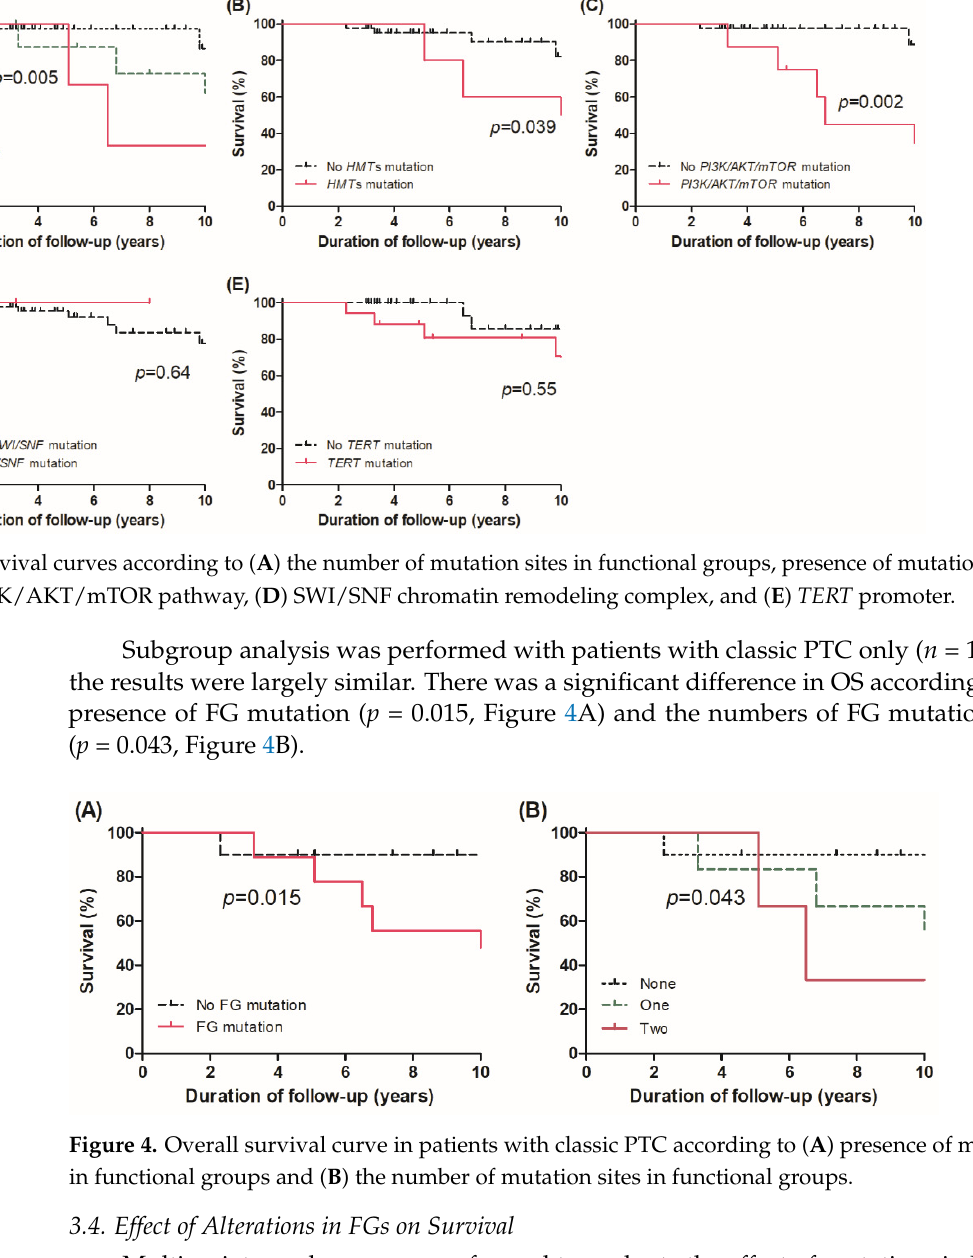
Figure 2. Overall survival curve ( A ) of patients with advanced PTC according to presence of mutations in functional groups and ( B ) among three genomic subgroups: BRAF V600E only (group 1) vs. BRAF V600E + additional mutations other than functional groups (group 2) vs. BRAF V600E + mutations in functional groups (group 3).